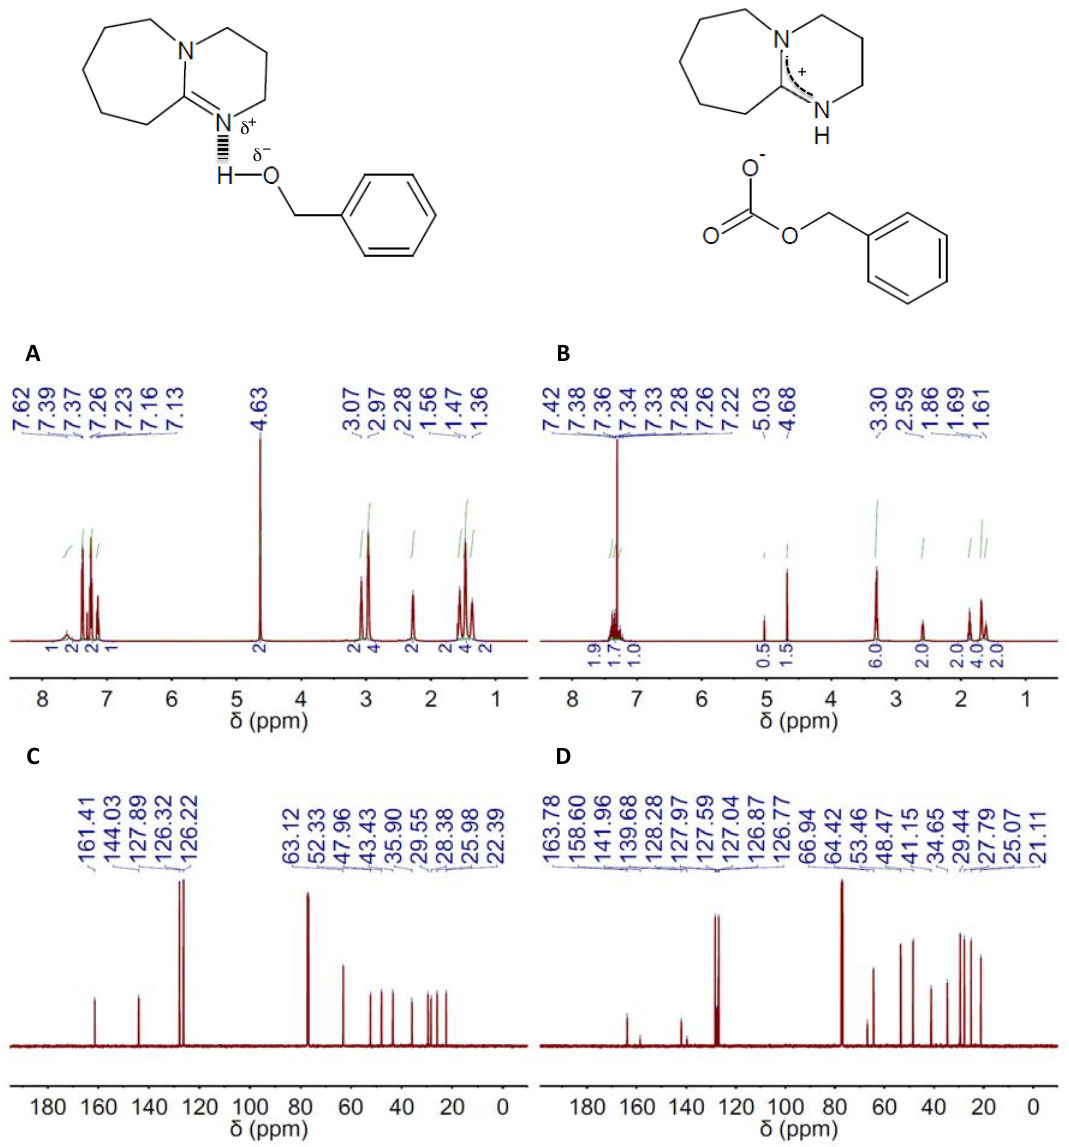
Figure 1. 1 H and 13 C NMR spectra (left and right columns, respectively) of the deep eutectic solvent (DES) composed of 2,3,4,6,7,8,9,10-octahydropyrimido[1,2- a ]azepine (DBU) and benzyl alcohol (BA) in a 1:1 molar ratio, e.g., DBU(1):BA(1), before ( A , C ) and after ( B , D ) CO 2 absorption. The chemical structures of both the DES resulting from H-bond interaction between DBU and BA in the DES and the salt formed upon CO 2 absorption on DES are also